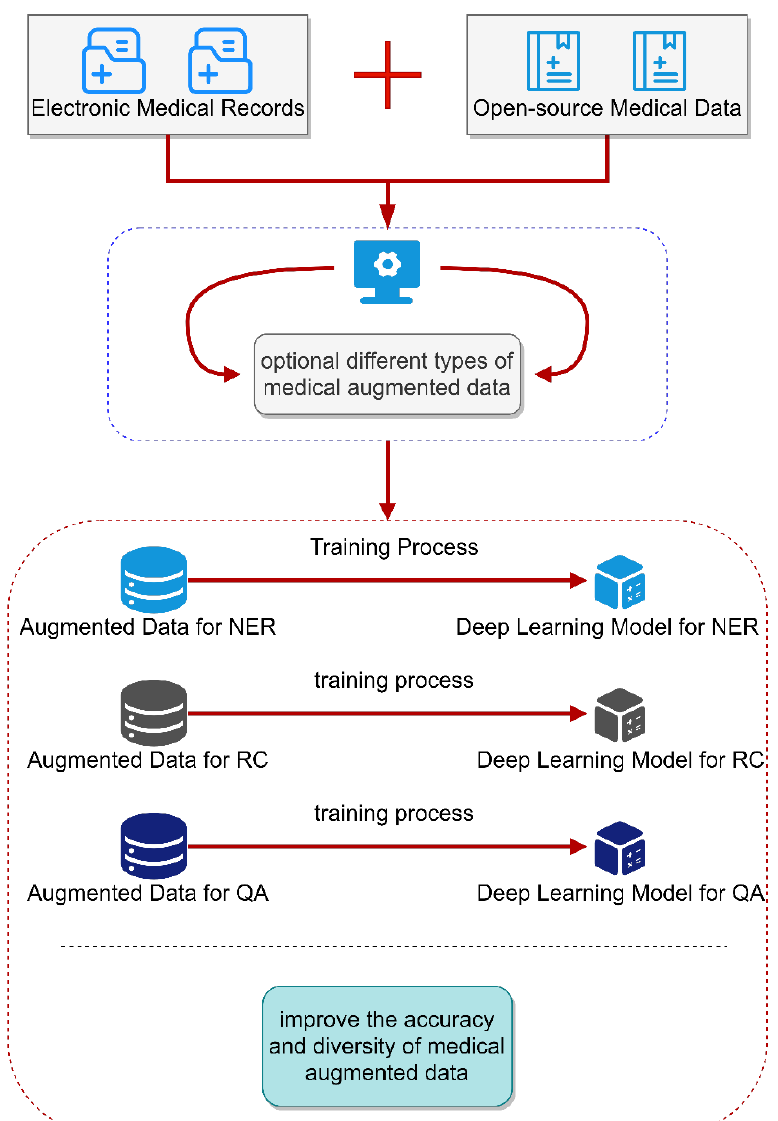
Figure 5. An application diagram of the MDA in natural language processing tasks.